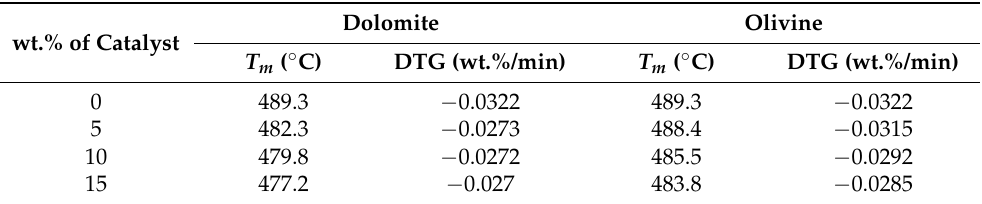
Table 4. DTG and values of T m of CO 2 gasification of Subcoal™ PAF with different loadings of the